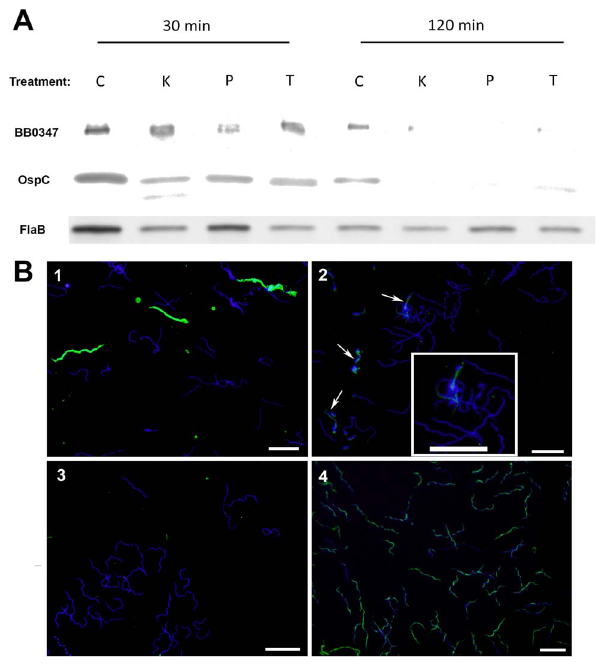
Figure 4. BB0347 is surface exposed in B.burgdorferi MI-16. A) Intact spirochetes were treated with different proteases for 30 min or 2 hrs. Western blots were run against whole cell lysates after these treatments and blotted with a BB0347, a OspC, or a FlaB. After two hours, no difference was observed between the control and protease-treated spirochetes in the a FlaB-blotted membranes, but OspC and BB0347 were almost completely degraded (Key: C: No protease control, K: proteinase K, P: pronase, T: trypsin). B) Intact bacteria were coated onto glass slides and fixed with 10% Formalin. Antibodies against the same proteins listed in (A) were used to stain and a secondary antibody conjugated with Dylight 488 was used for detection. DAPI was used as a secondary stain to localize spirochetes (see Materials and Methods). An additional control in which the B. burgdorferi membrane was compromised by desiccation, was included to verify that a FlaB antibodies were effective on fixed spirochetes. Key: Panel 1) a OspC, 2) a BB0347, 3) a FlaB 4) a FlaB with membrane disruption. BB0347 was detected in intact spirochetes, further verifying the surface exposure. White bars indicate a length of 10 m M, and the magnification is 1000 6 . Results are indicative of three independent experiments with similar